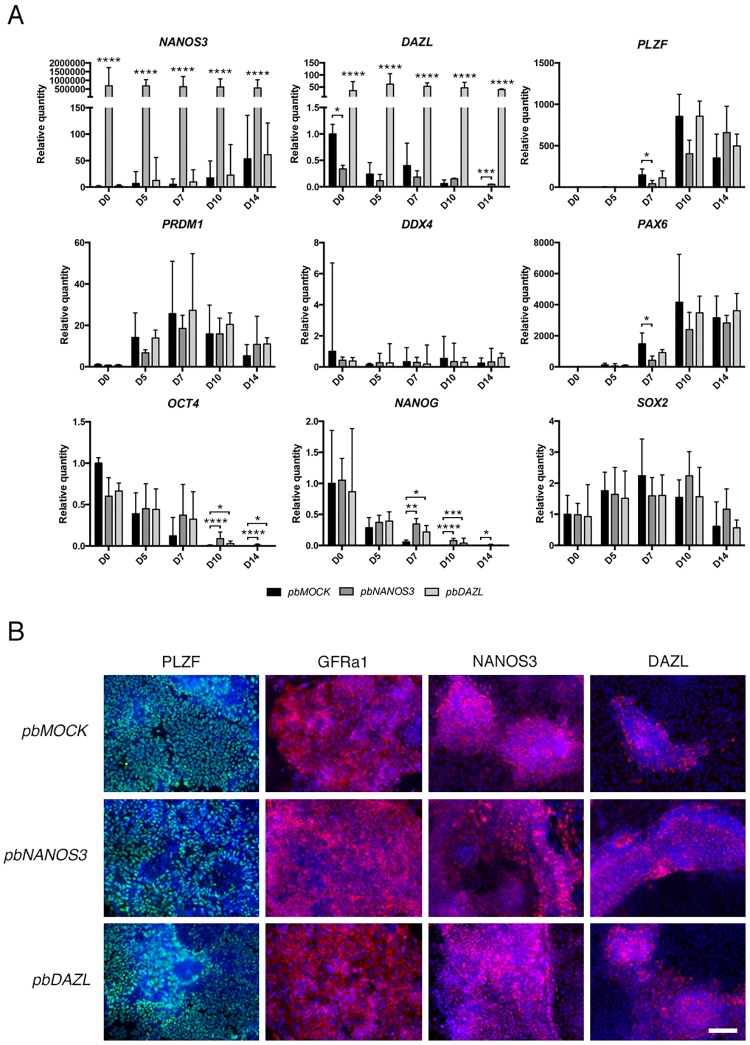
Analysis of in vitro differentiated pbNANOS3 and pbDAZL cells.A) Gene expression analysis for cells differentiated on SNL-feeders using SSC medium for 5, 7, 10 or 14 days, and for cells in undifferentiated culture conditions (D0). Samples from three separate experiments were used at passage 6–8 after transfection. Values are relative quantities normalized to GAPDH and RPLPO, and represented as mean ± SD. Statistical significance was tested by two-way ANOVA, **** p < 0.0001, *** p < 0.001, ** p < 0.01, * p < 0.05. See also S3 Table. B) Immunofluorescence staining of transfected cells differentiated for 14 days on SNL-feeders; PLZF (green), GFRa1 (red), NANOS3 (red) and DAZL (red). Cells were counterstained with DAPI (blue). Scale bars: 100 μm. See also S3 Fig.